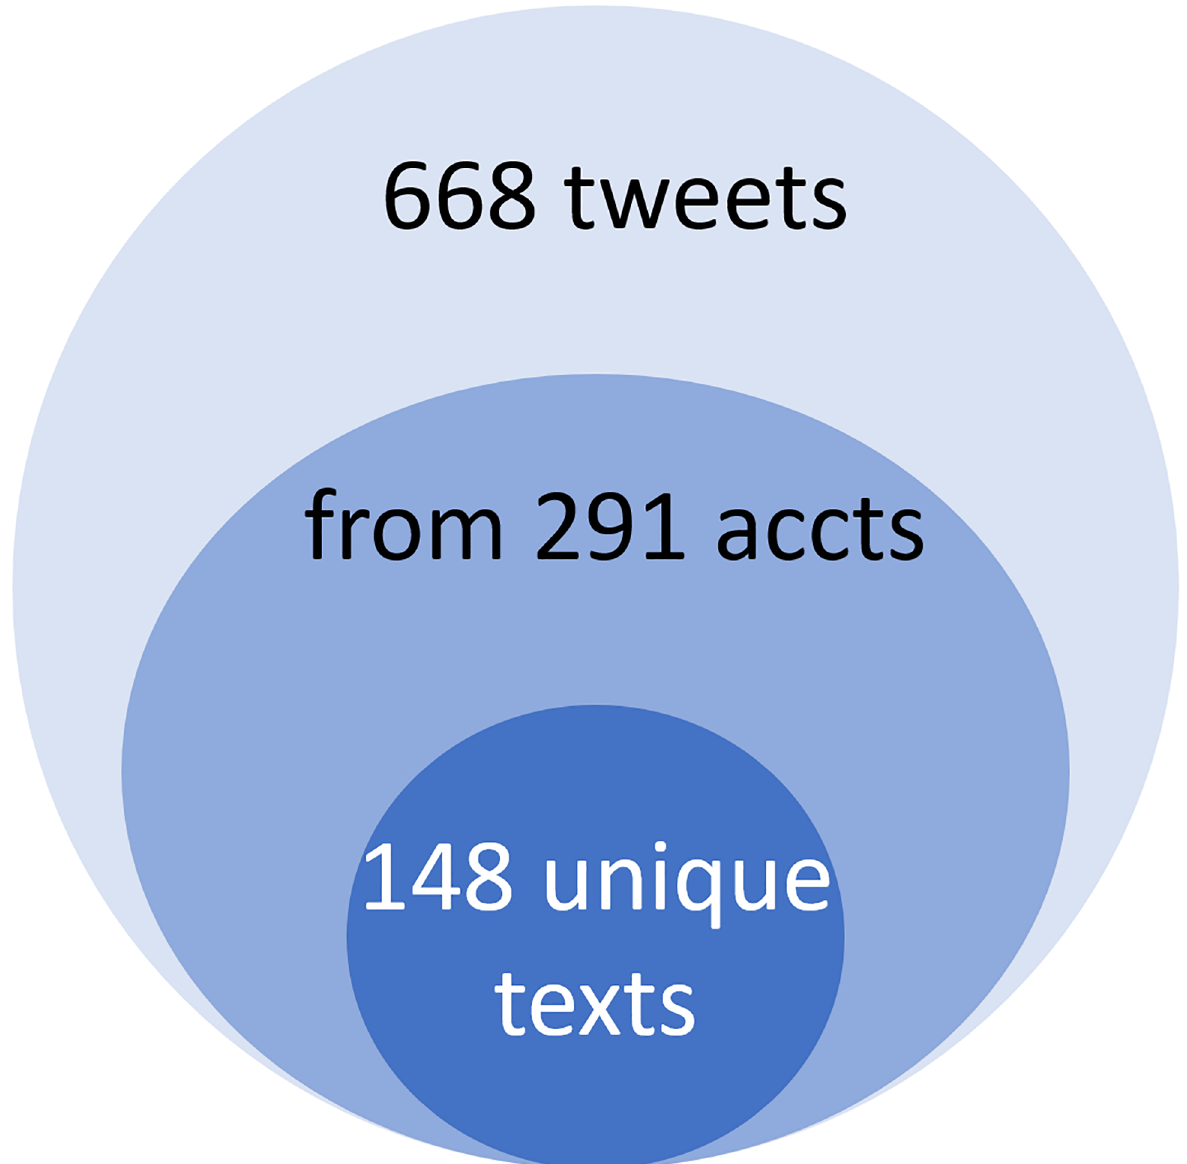
Fig 1. Metrics for the group of 10 most tweeted